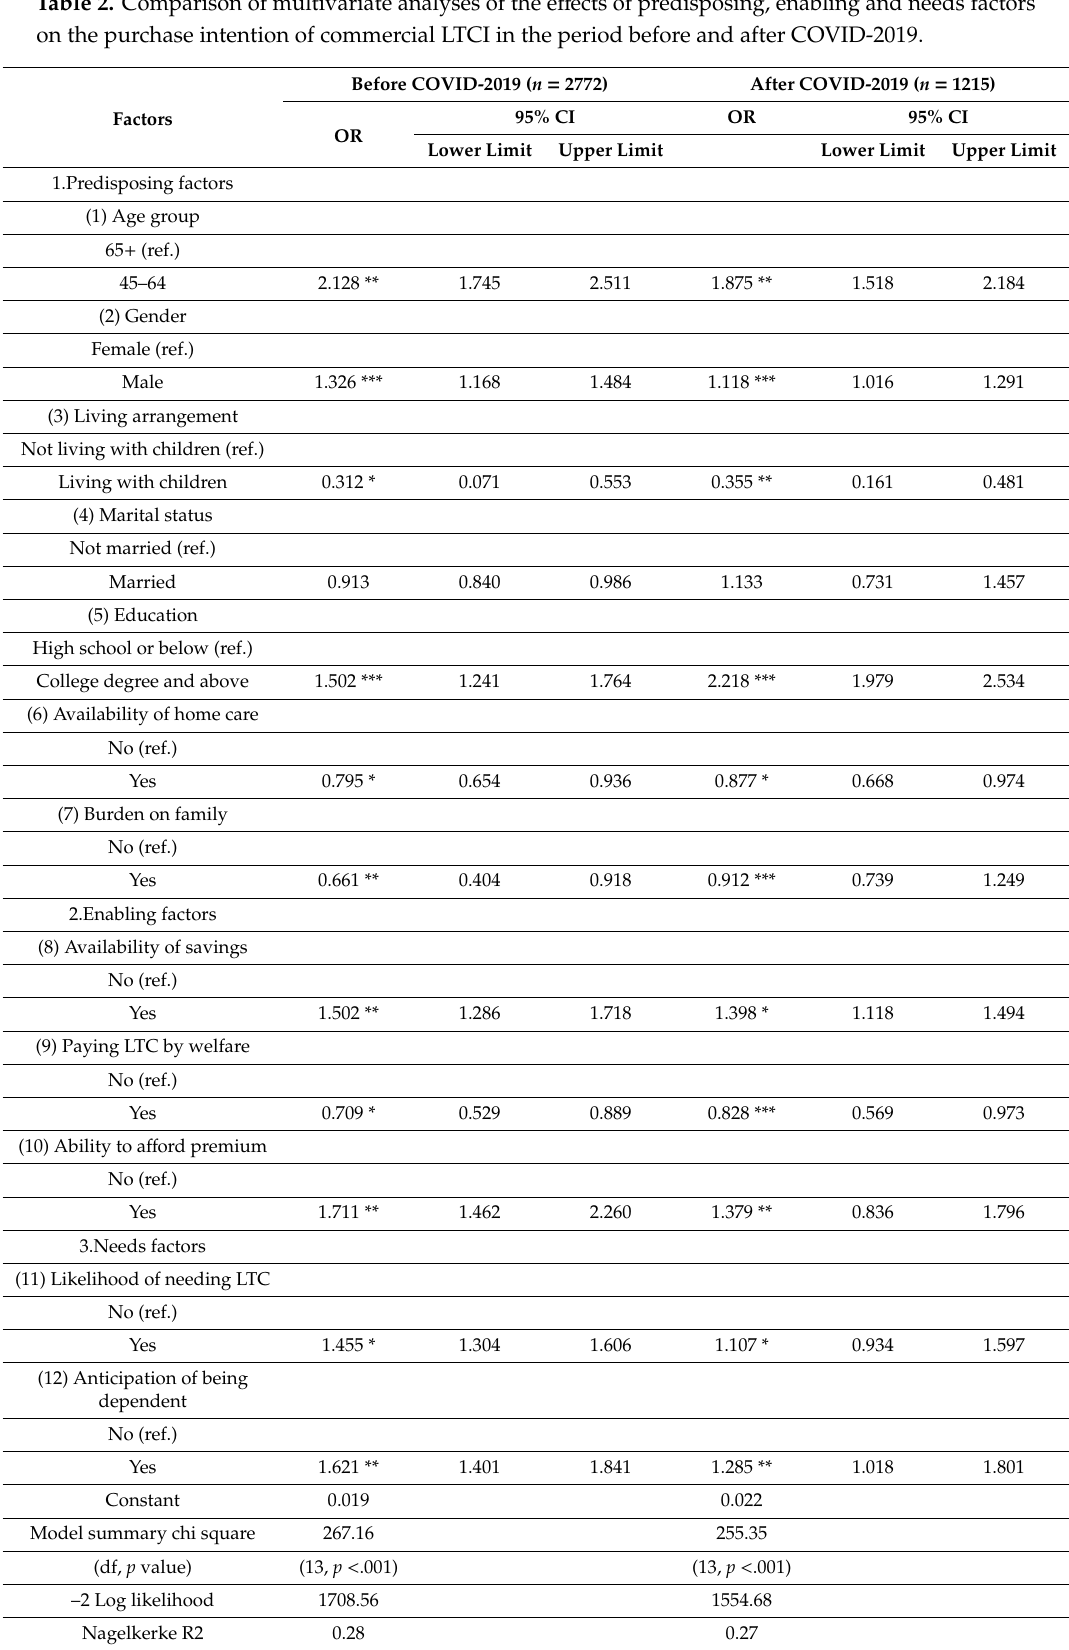
Table 2. Comparison of multivariate analyses of the e ff ects of predisposing, enabling and needs factors on the purchase intention of commercial LTCI in the period before and after